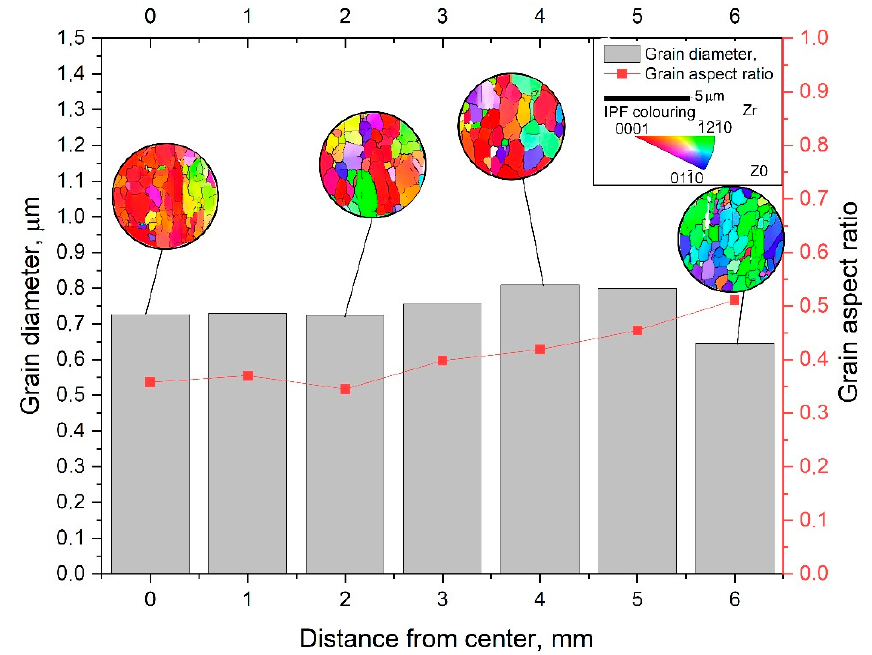
Figure 10. The final rolled sample cross-section structure EBSD study.